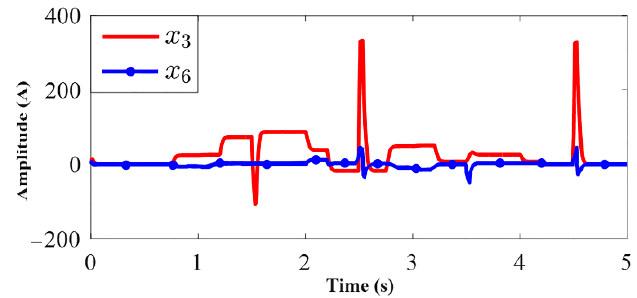
Figure 11. Inductance L 3 and L 6 voltages during fault occurrence.